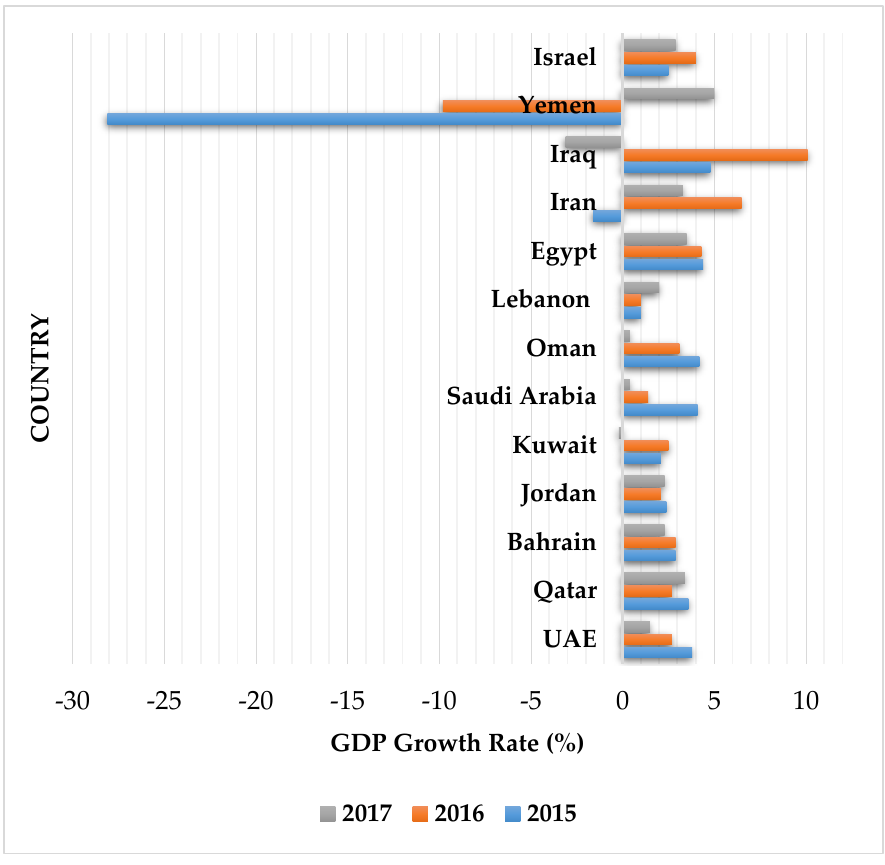
Figure 7. Actual GDP Growth rate for the years of 2015 − 2017. The data is acquired from: IMF Data Mapper.